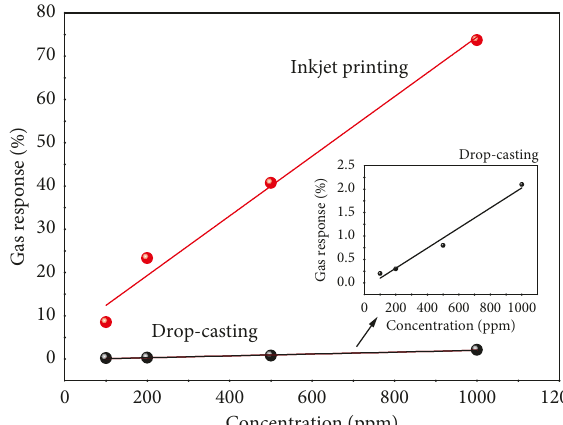
Figure 12: Gas responses of fabricated gas sensors prepared by drop-casting and inkjet printing as a function of NH temperature.